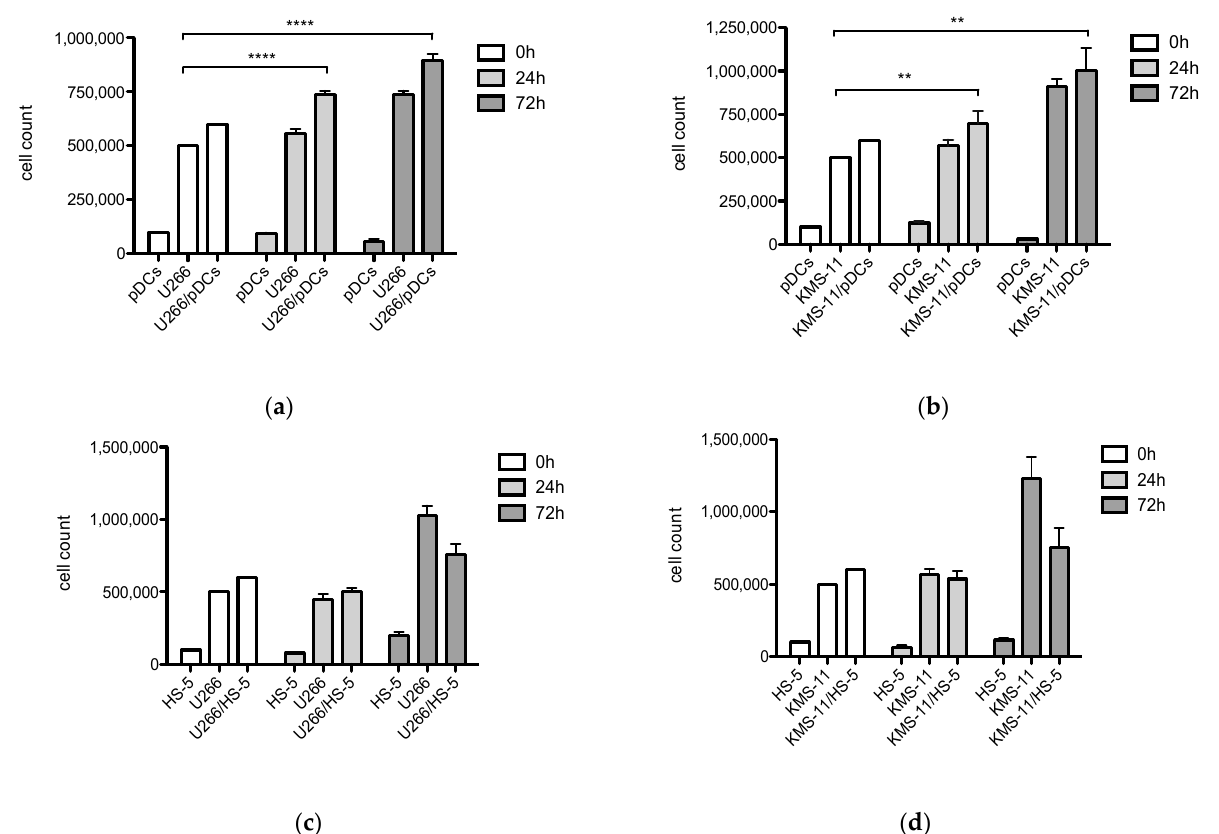
Figure 3. Expansion of myeloma cells in the presence of pDCs: ( a ) Proliferation of MM cell lines including U266 (5 × 10 5 cells/1 mL); ( b ) KMS-11 (5 × 10 5 cells/1 mL) alone and in the presence of freshly sorted pDCs (10 5 cells/1 mL) at a 5:1 ratio for 24 h (pale grey) and 72 h (dark grey) co-cultured in 24-well plates; ( c ) Proliferation of MM cell lines including U266 (5 × 10 5 cells/1 mL); ( d ) KMS-11 (5 × 10 5 cells/1 mL) alone and in the presence of the HS-5 cell line (10 5 cells/1 mL) at a 5:1 ratio for 24 h (pale grey) and 72 h (dark grey) co-cultured in 24-well plates. Data are shown as mean ± SD from three independent experiments. Significant differences in pDC co-cultures were determined using the unpaired t test as **** p < 0.0001 (U266) and ** p = 0.002 and p = 0.007 (KMS-11) respectively.